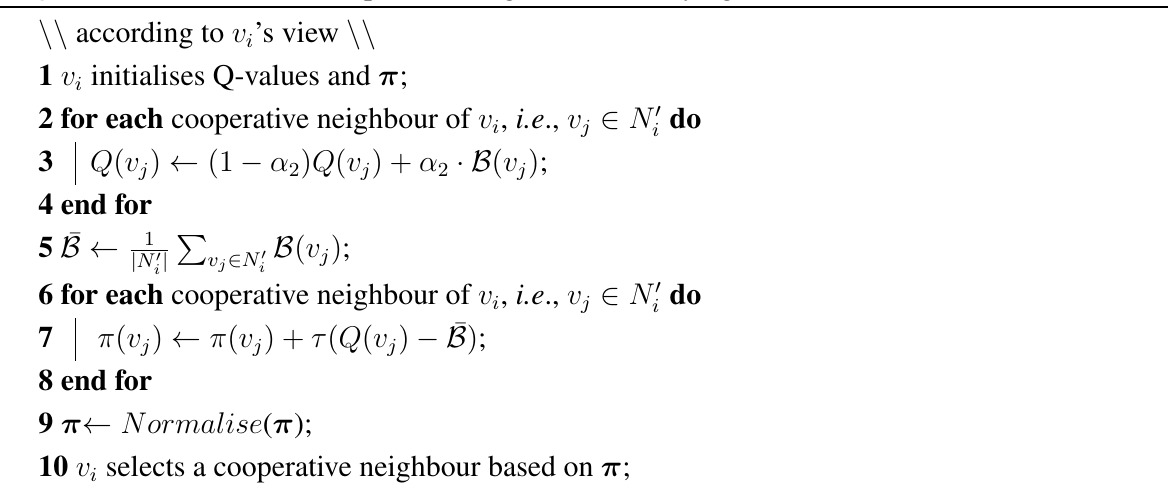
Algorithm 2. Choice of a cooperative neighbour for relaying \\ according to v ’s view i